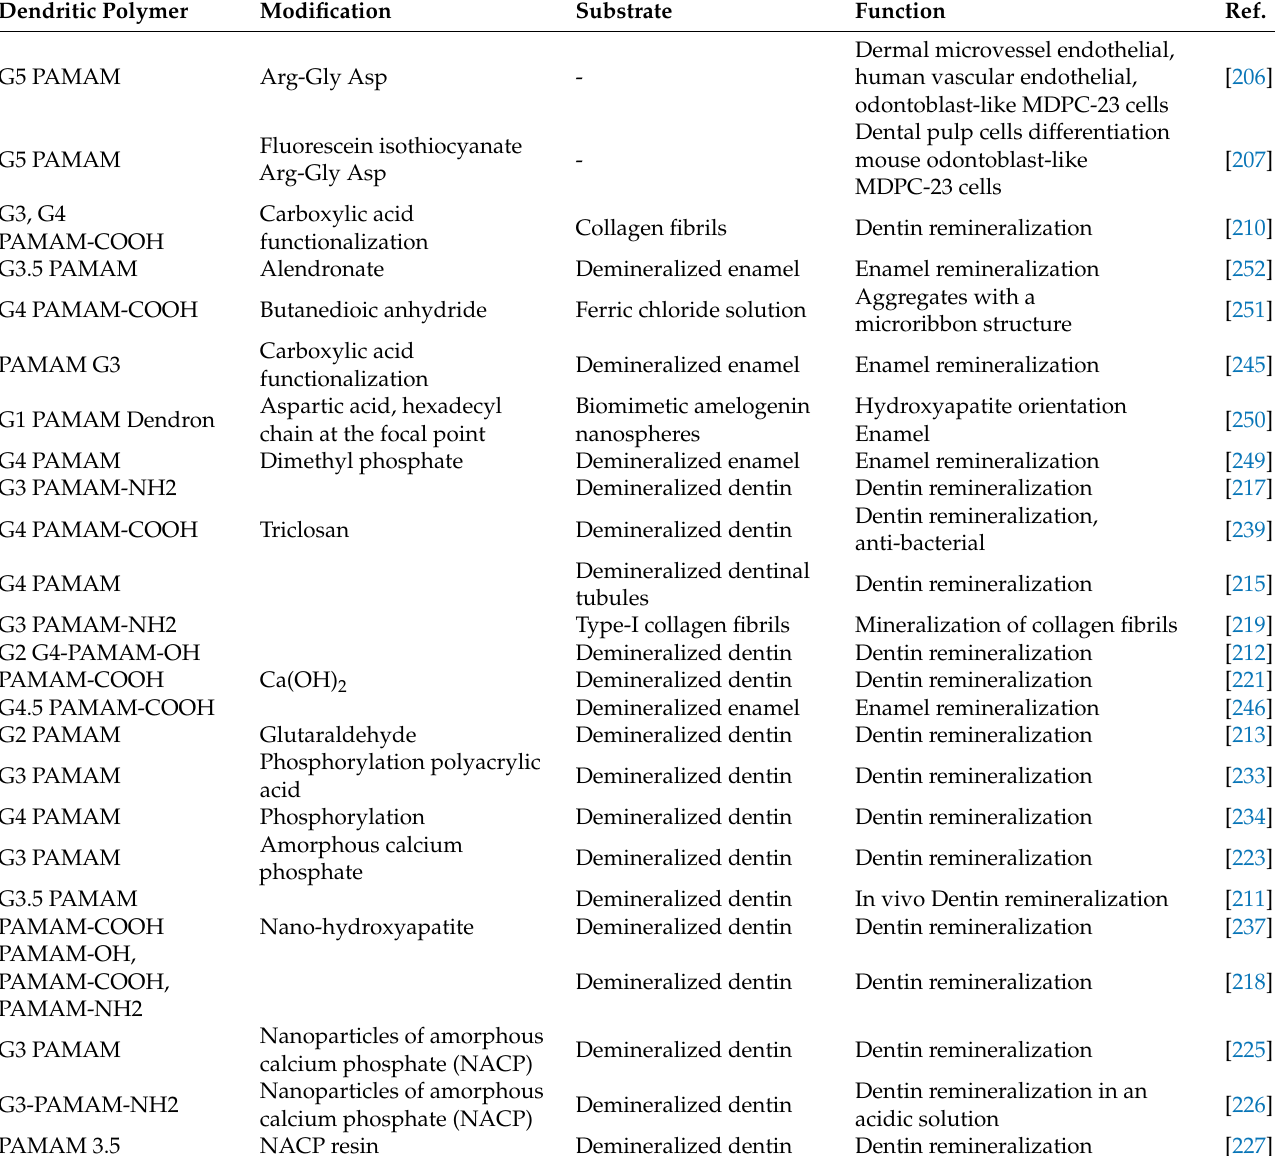
Table 4. Dendritic polymers in